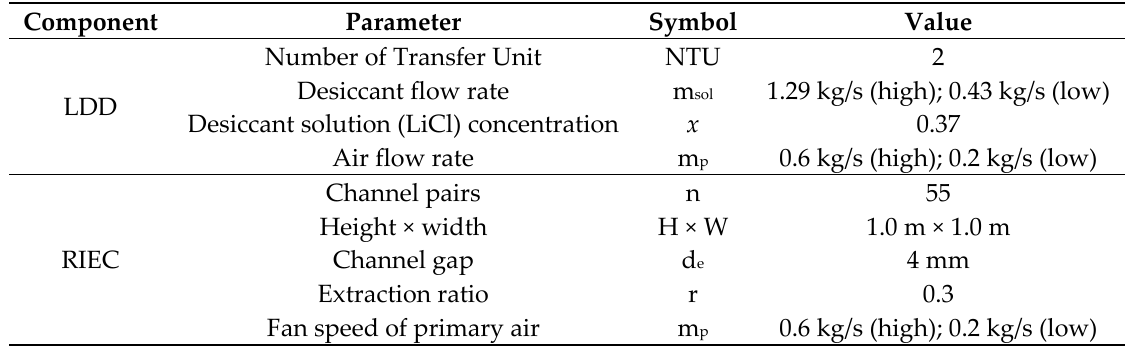
Table 1. Structure and operational parameters of LDD and